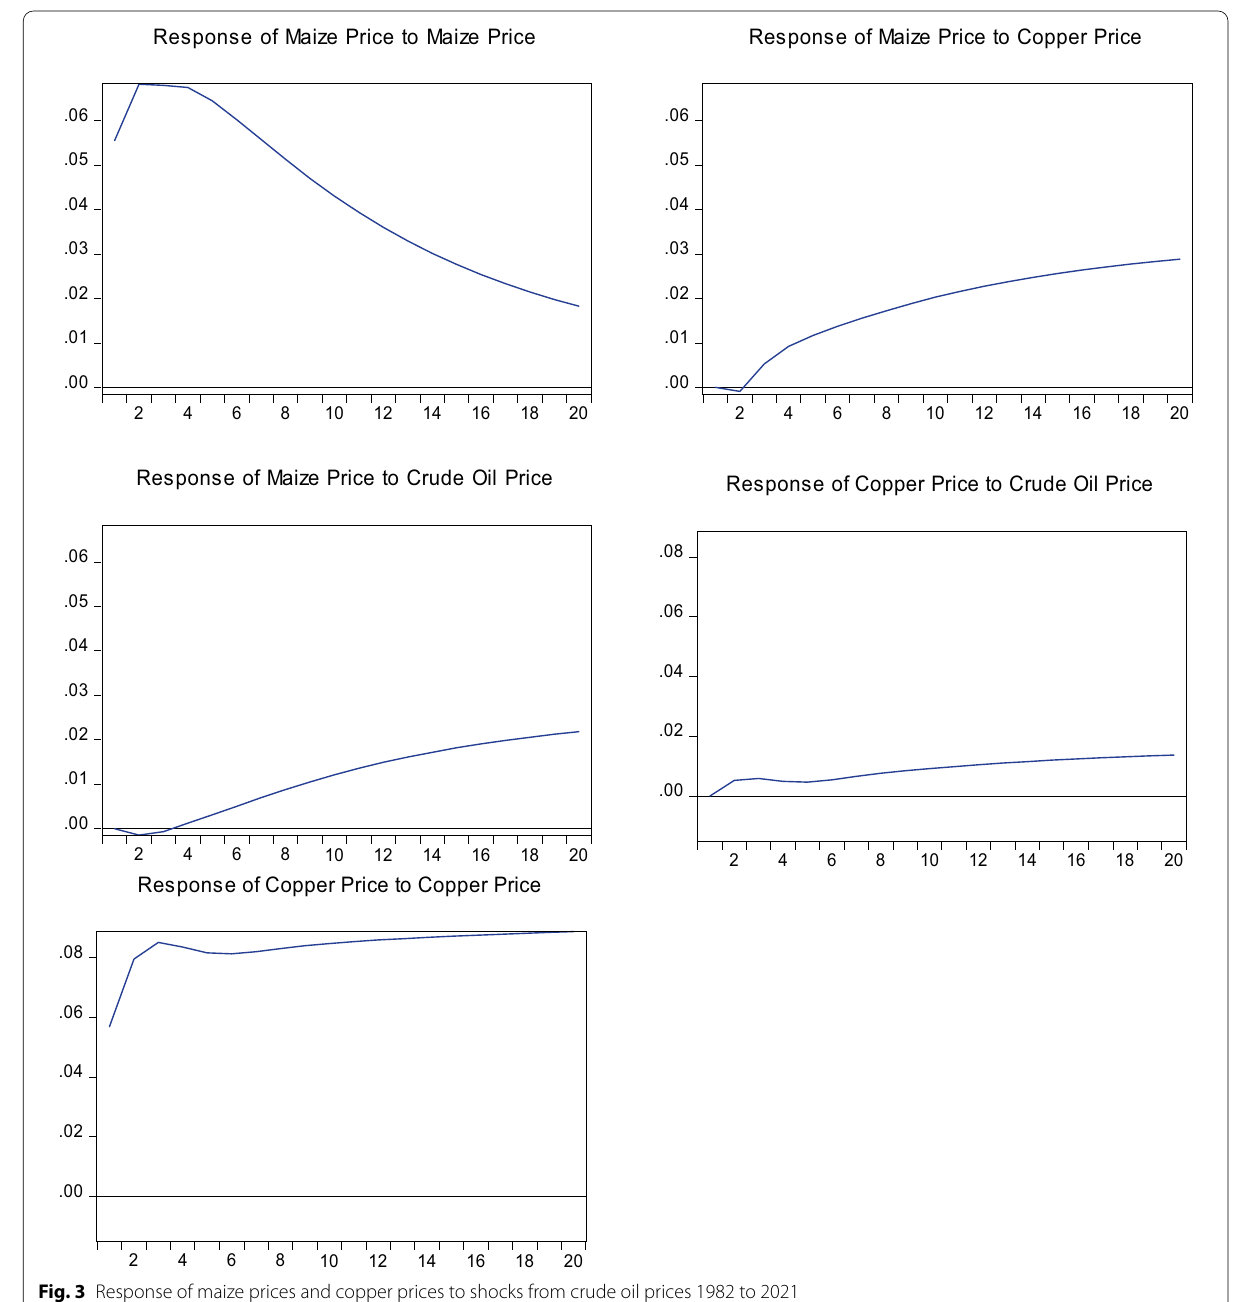
Fig. 3 Response of maize prices and copper prices to shocks from crude oil prices 1982 to